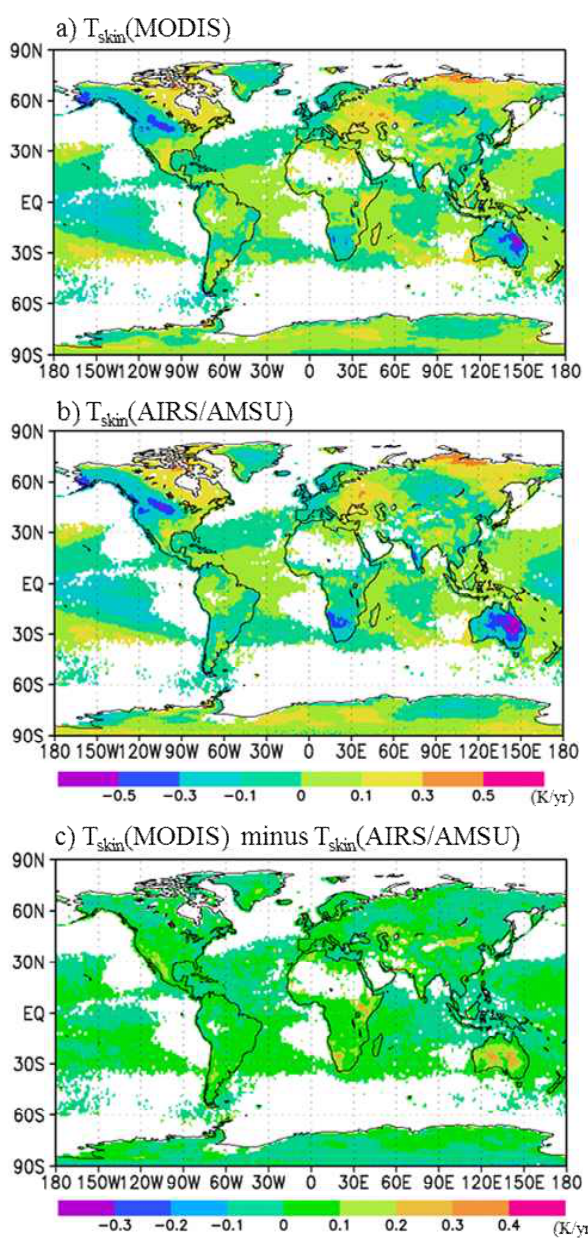
Fig. 6. Satellite-derived monthly temperature anomaly trends (Kyr − 1 ) in a grid box of 1 ◦ × 1 ◦ over the globe during the period from September 2002 to August 2011 for the (a) T skin (MODIS) and (b) T skin (AIRS/AMSU), and (c) the difference in thermal Figure 6. Satellite-derived monthly temperature anomaly trends (K yr -1 ) in a grid box of 1°×1° 3 trend between the two temperatures (i.e. T skin (MODIS) minus T skin over the globe during the period from September 2002 to August 2011 for the a) 4 (AIRS/AMSU)). T (MODIS) and b) T (AIRS/AMSU), and c) the difference in thermal trend between the 5 skin skin two temperatures (i.e., T (MODIS) minus T skin